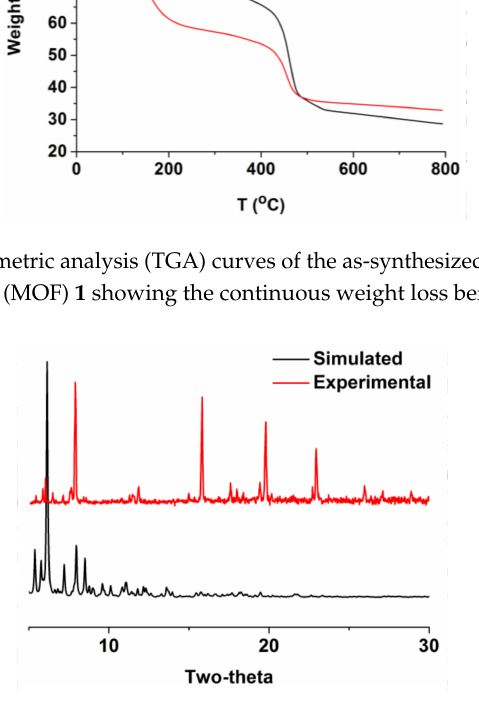
Figure 2. The powder X-ray diffraction (PXRD) of MOF 1 showing the simulated (black) and the experimental (red)